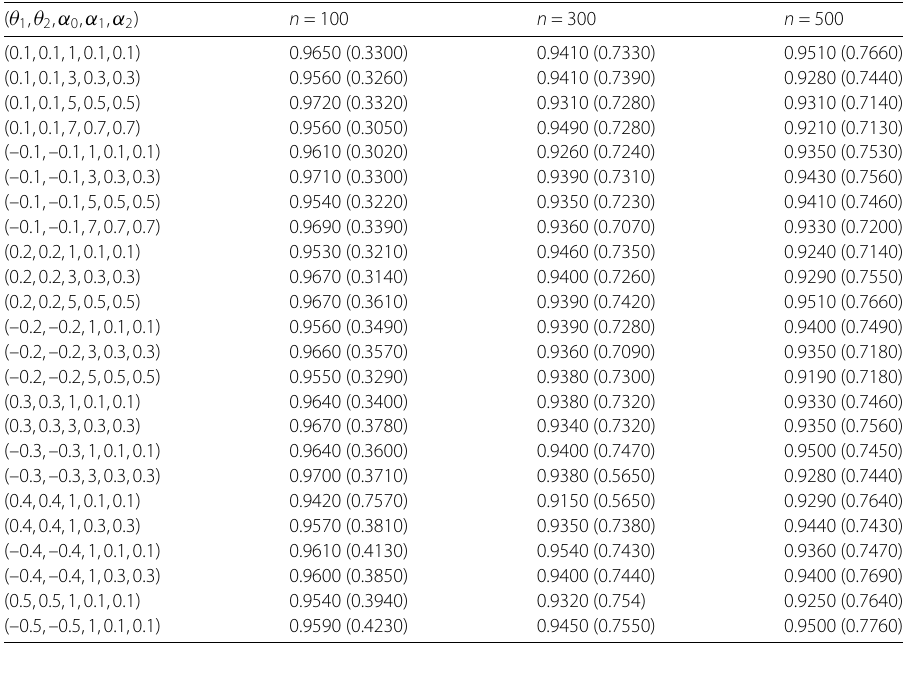
Table 5 The simulation results for sequence III ( (cid:9) , σ , k ) = (0.5,1,3) ( θ 1 , θ 2 , α 0 , α 1 , α 2 )